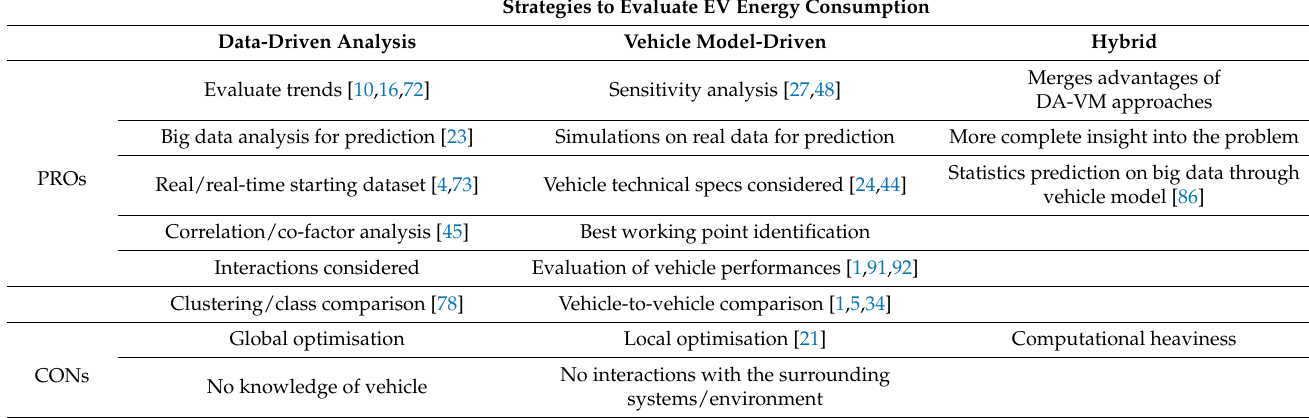
Figure 8. Hybrid approach for EV modelling. Table 5. Different strategies to model the EV problems. Synthetically groups the pros and cons of the modelling approaches.